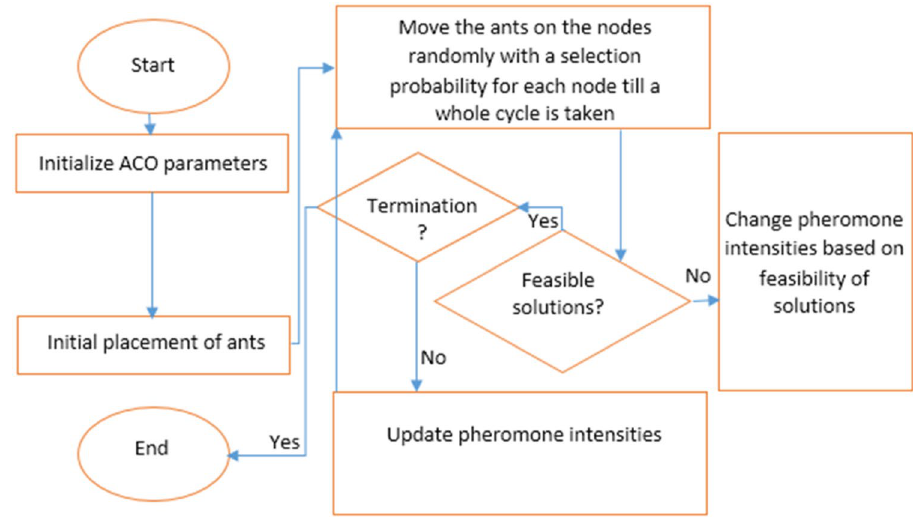
Fig. 7 Flowchart of a gen-